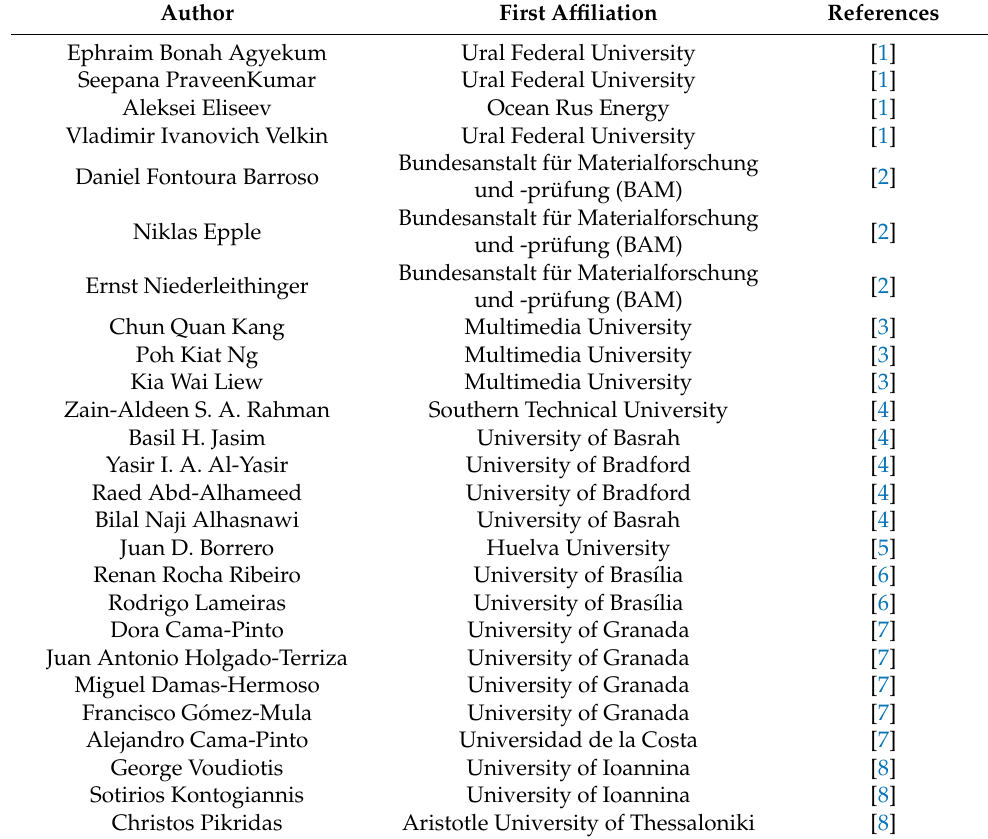
Table 2. Authors’